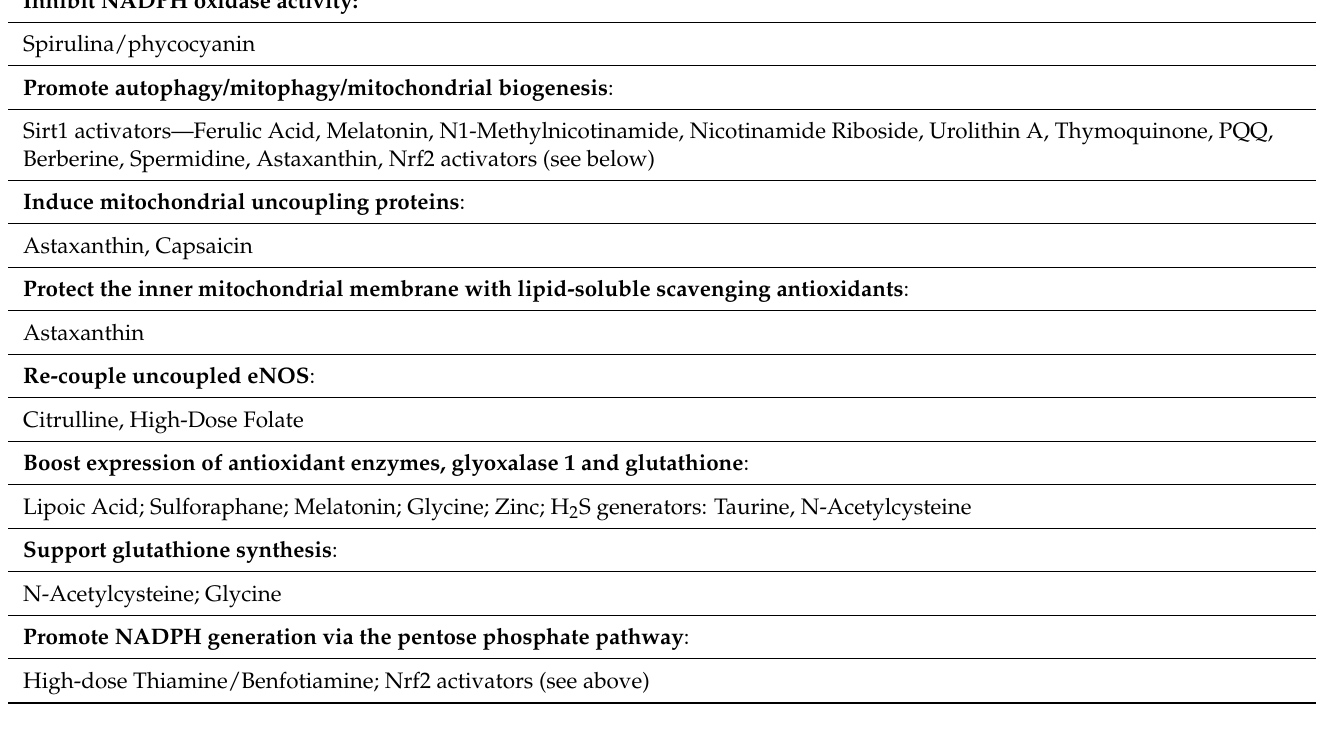
Table 2. Supplementation Program for